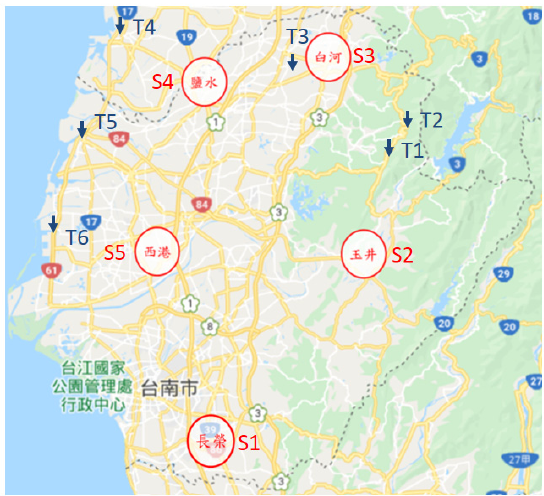
Figure 14. GTS deployment and site test, S1~S5 and T1~T6 in the northern part of Tainan City.